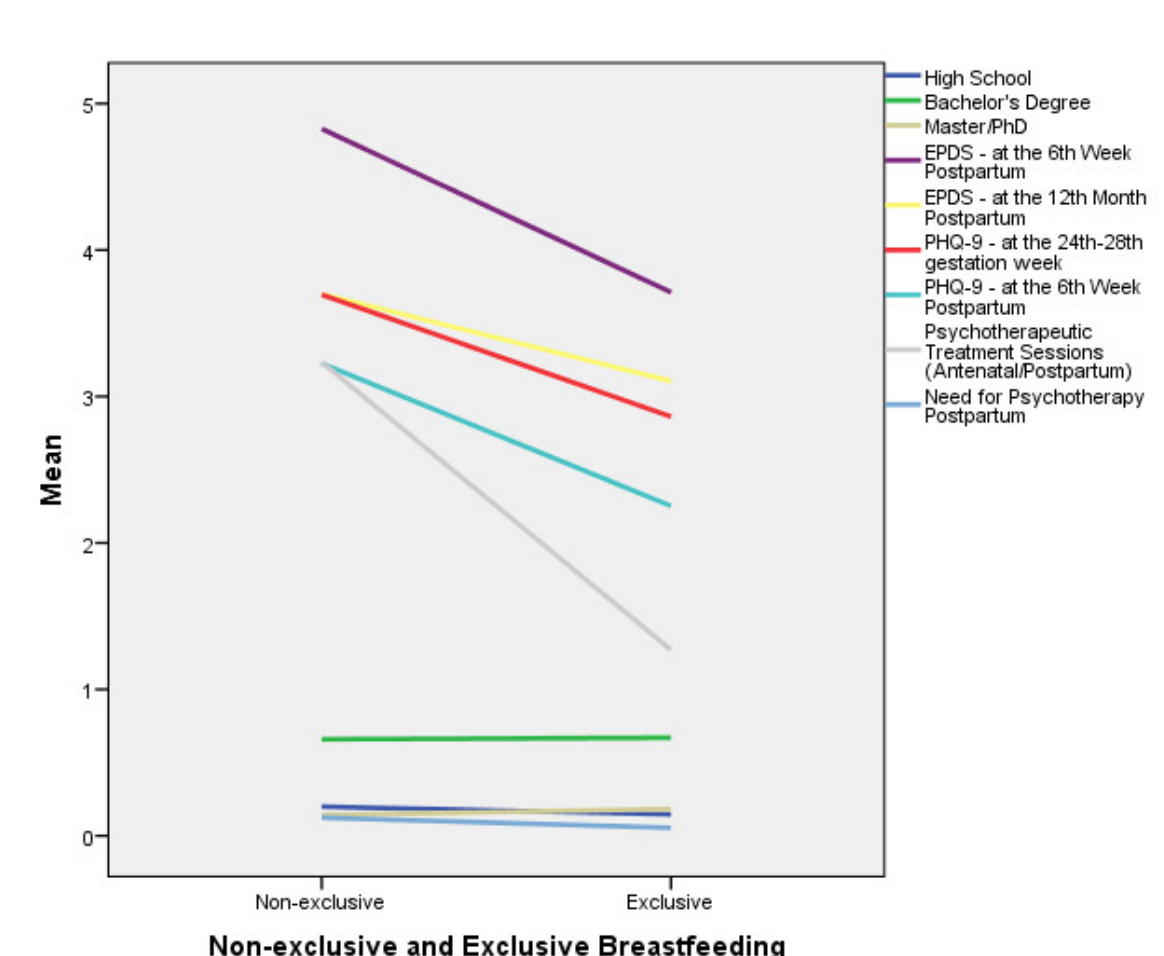
Figure 1. The relationship between exclusive breastfeeding at the end of the 6th month postpartum and independent variables according to the logistic regression analysis model. Table 3. Logistic regression analysis model with exclusive breastfeeding at the end of the 6th month postpartum as the dependent variable.